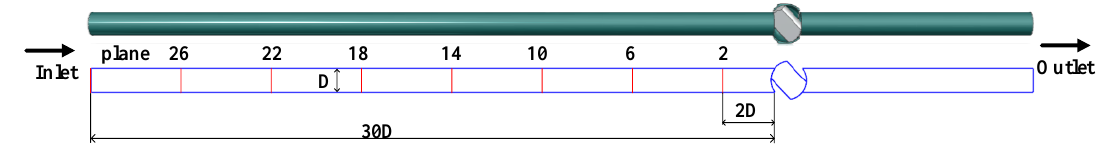
Figure 2. The calculation domain of the water hammer of the ball valve.